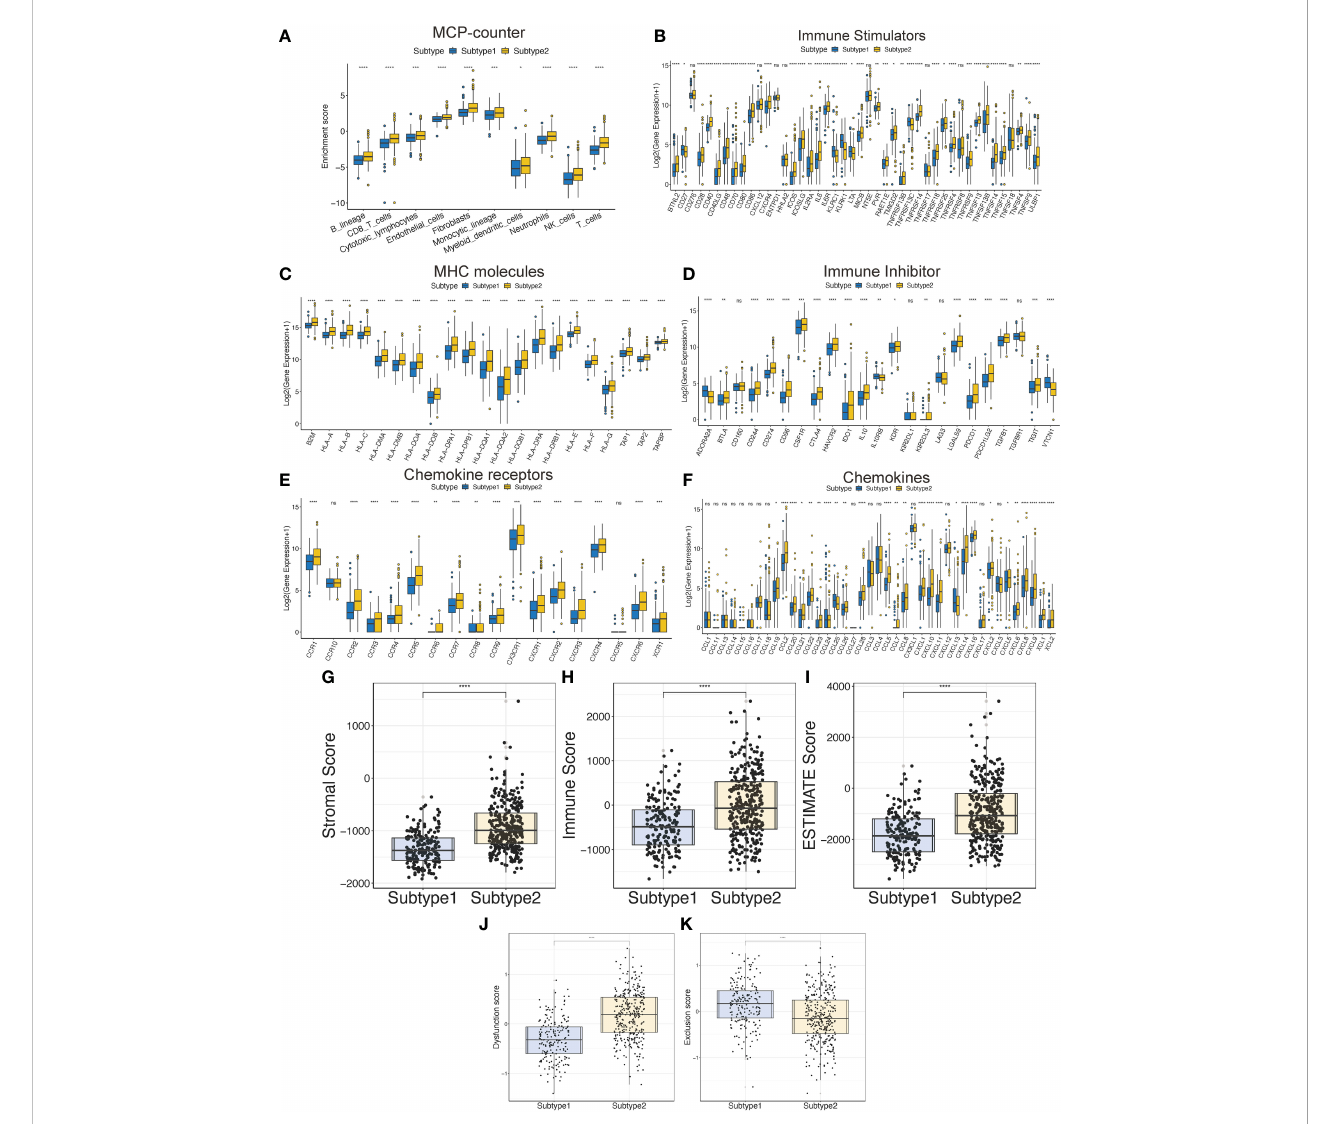
FIGURE 3 The tumor immune microenvironment characteristics between the TPR subtypes. (A) The immune cell in fi ltration was assessed via the MCP-counter algorithm in the TCGA-LGG cohort. (B-F) The expression of immune-related genes between the two subtypes in the TCGA-LGG cohort, including immune stimulators (B) , MHC molecules (C) , immune inhibitors (D) , chemokine receptors (E) , and chemokines (F) . (G-I) The ESTIMATE-related scores of the two subtypes in the TCGA-LGG cohort, including stromal score (G) , immune score (H) , and ESTIMATE score (I) . (J, K) T cell dysfunction and T cell exclusion scores between the two subtypes in the TCGA-LGG cohort were assessed via the ssGSEA algorithms. *p<0.05, **p<0.01, ***p<0.001, ****p<0.0001, ns: no signi fi cant